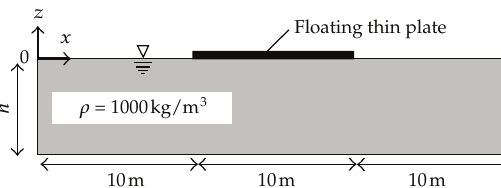
Figure 3: Computational domain with a thin plate floating on a one-layer fluid. The condition corresponds to that of Figure